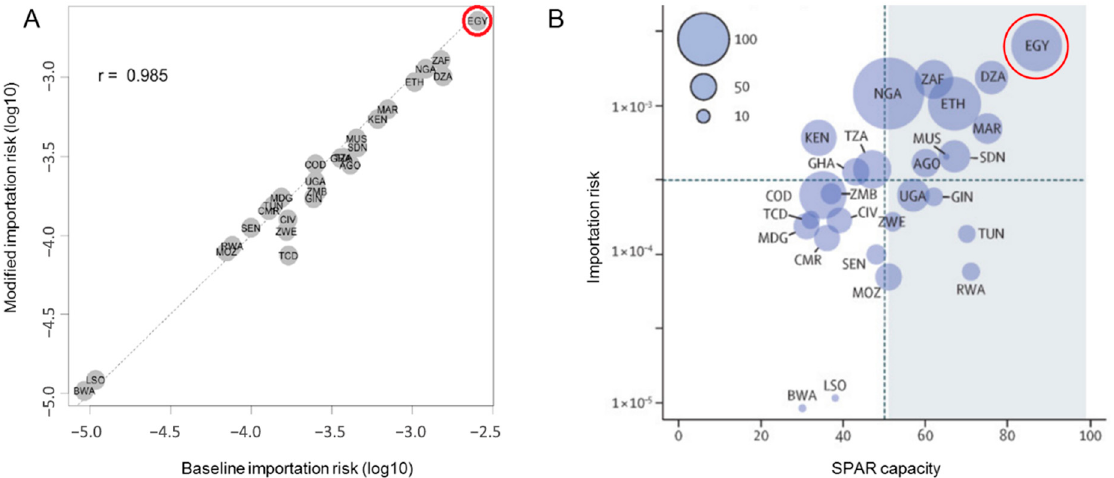
Figure 2. ( A ) Illustrates a scatter plot model of modified importation risk vs. baseline risk. Egypt is circled in red. ( B ) represents the importation risk of COVID-19 from China as a function of State Party Self-Assessment Annual Reporting (SPAR). Egypt is circled in red (reprinted with permission from Elsevier [6]. Copyright 2020 The Lancet ).